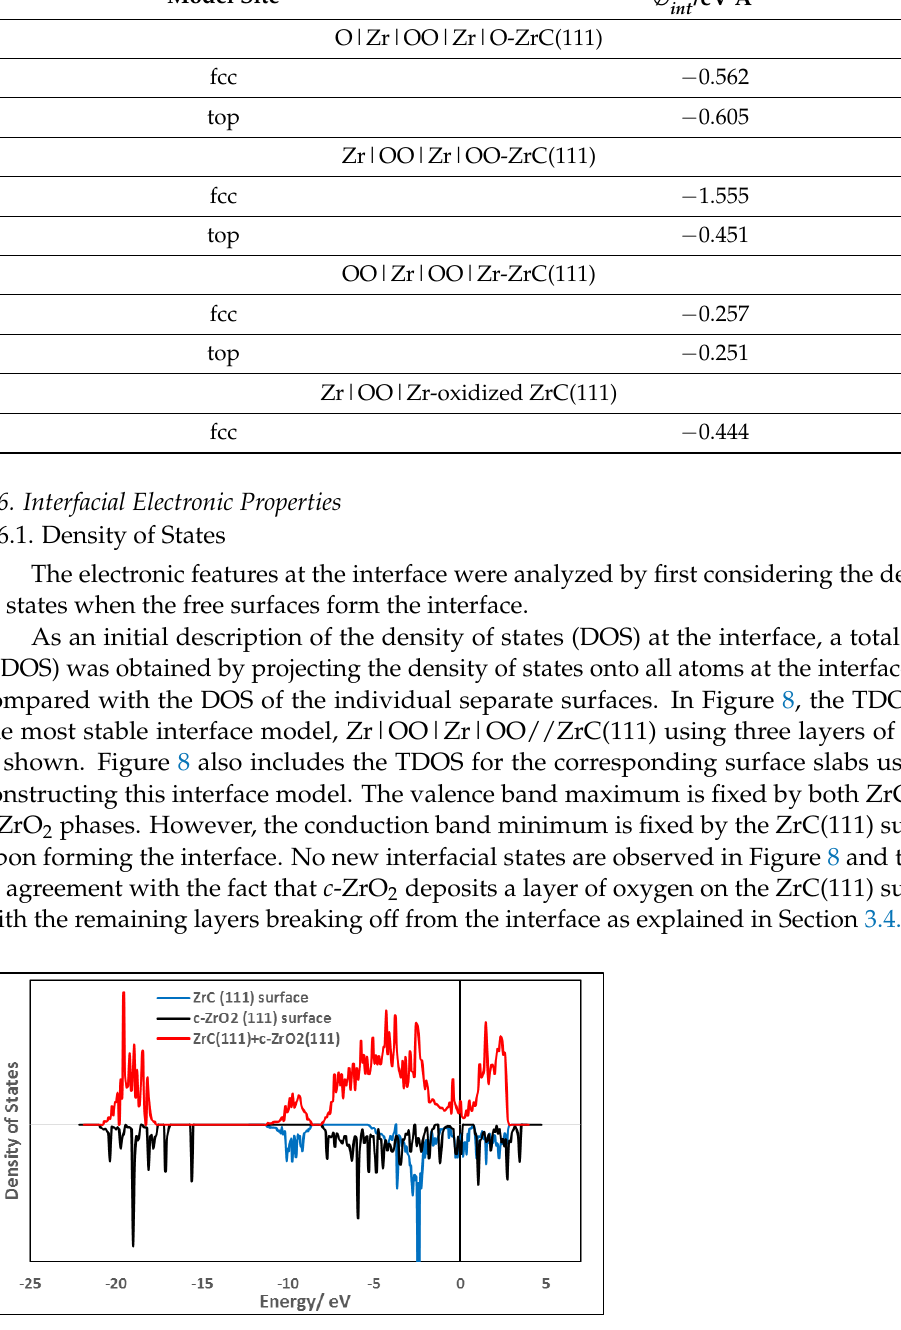
Table 4. Interface dependent terms of the interface grand potential ∅ i / j